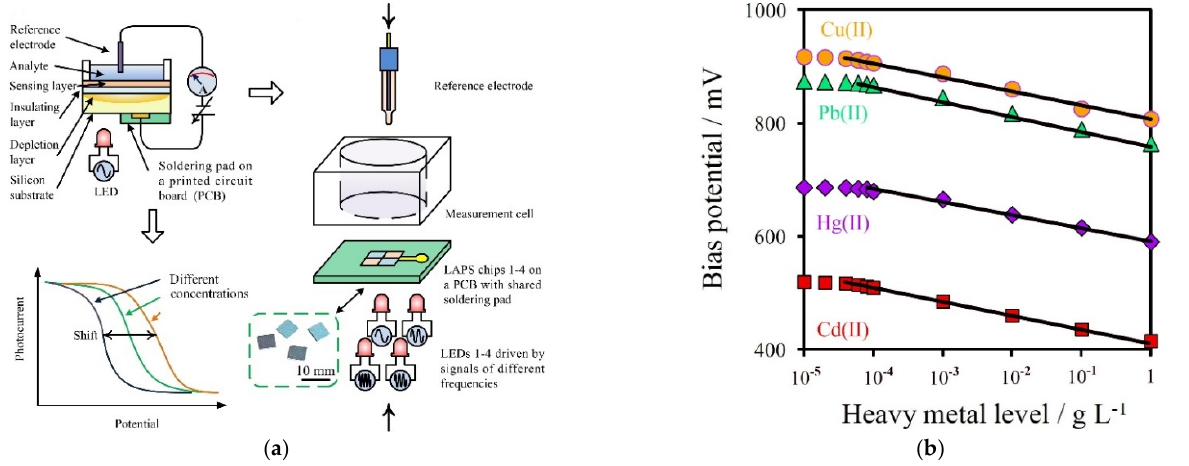
Figure 5. ( a , b ) A rapid method for the tracing of Cd (II), Pb (II), Cu (II) and Hg (II) in fish tissues [12].